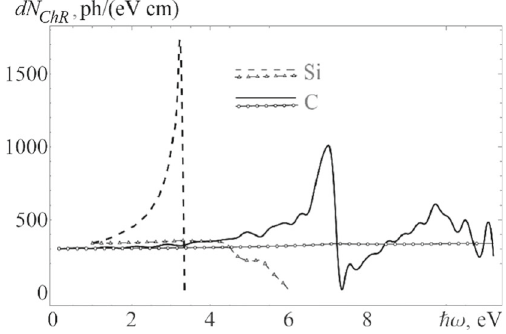
Fig. 2 Spectral distributions of ChR photons per unit path and unit energy calculated for both C (diamond) and Si crystals with the disper- sion taken into account (solid line) and without it (at G (ω) = 1, dashed line)